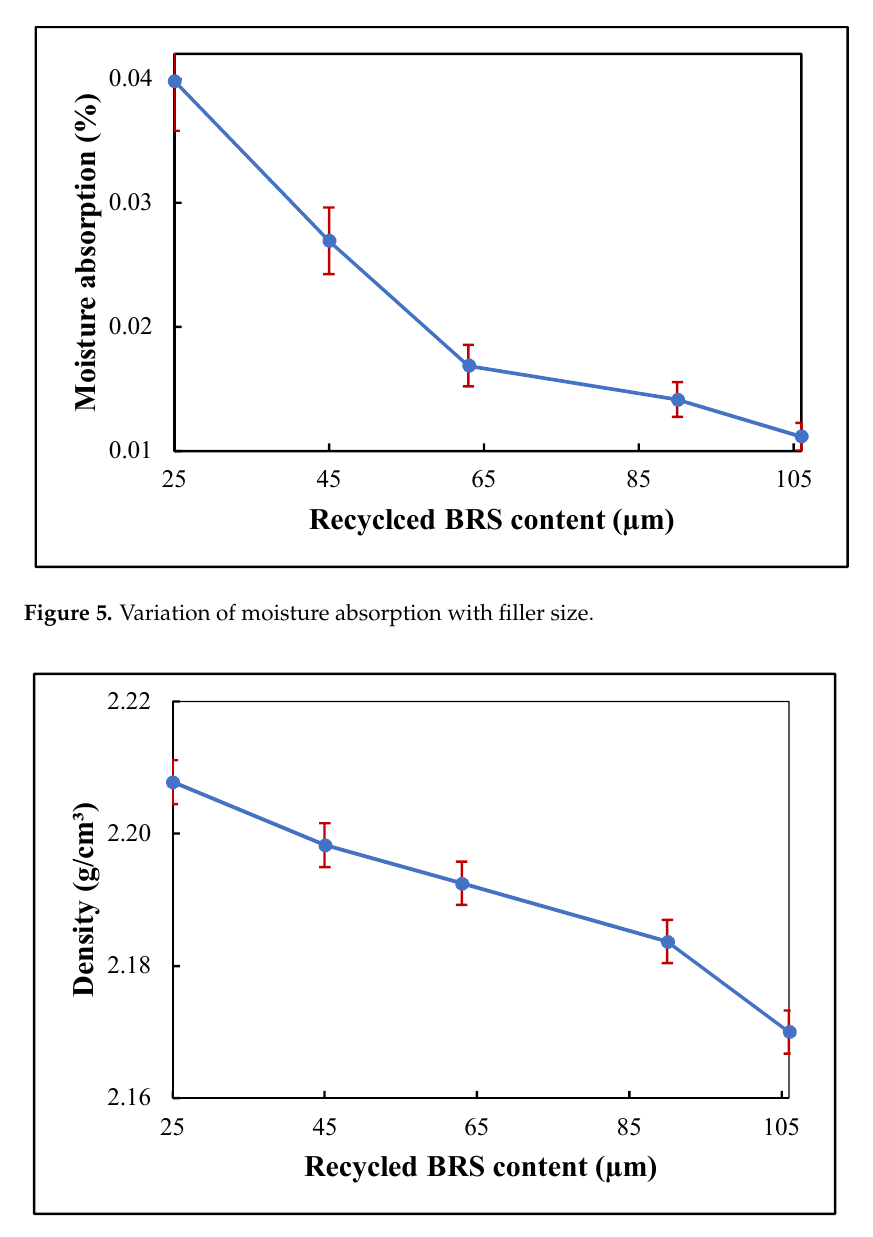
Figure 6. Variation of density with filler size.